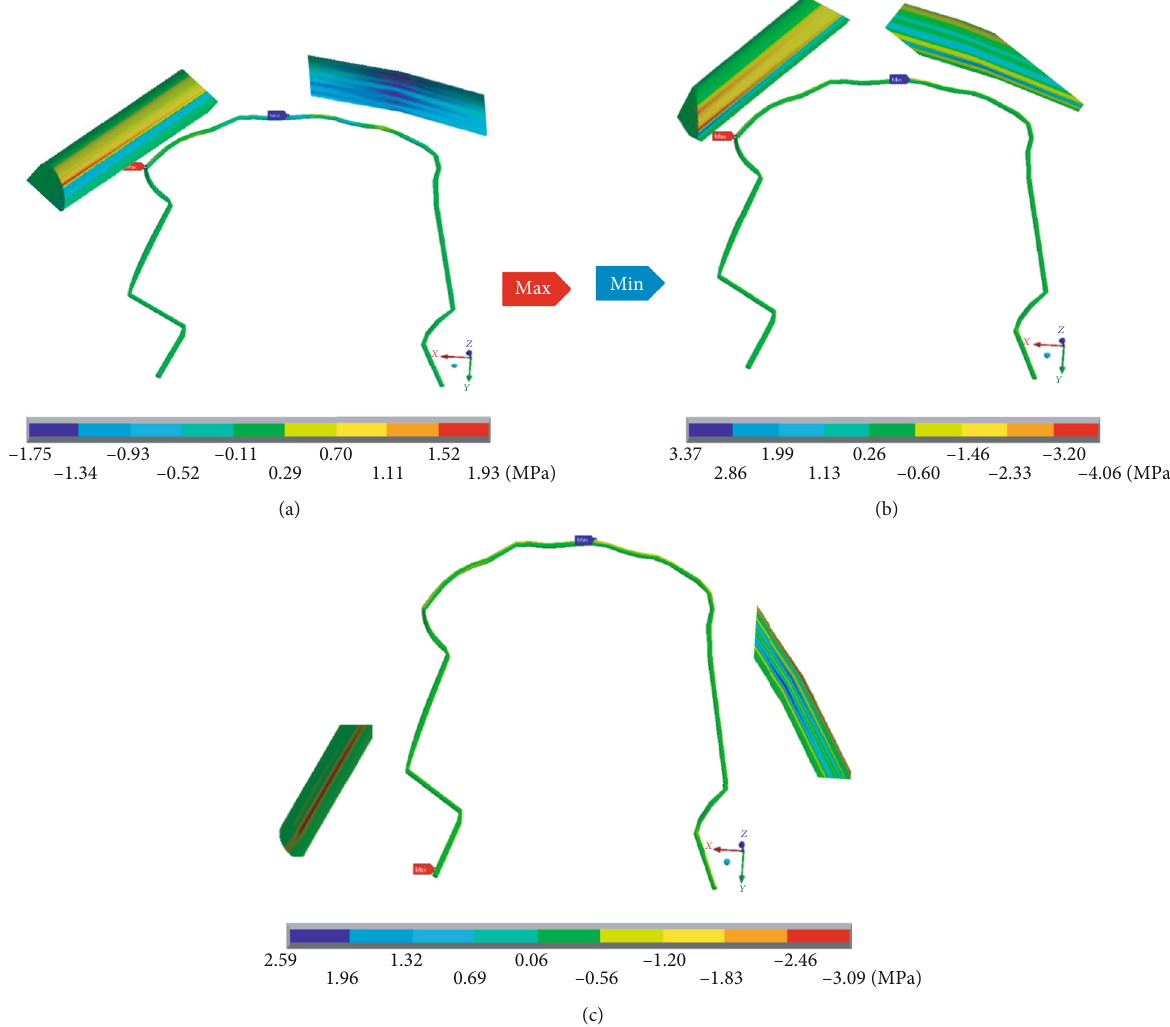
Figure 19: Normal stresses in the wire: (a) X axis; (b) Y axis; (c) Z axis. The red marker indicates the maximum stresses, and the blue marker indicates the minor